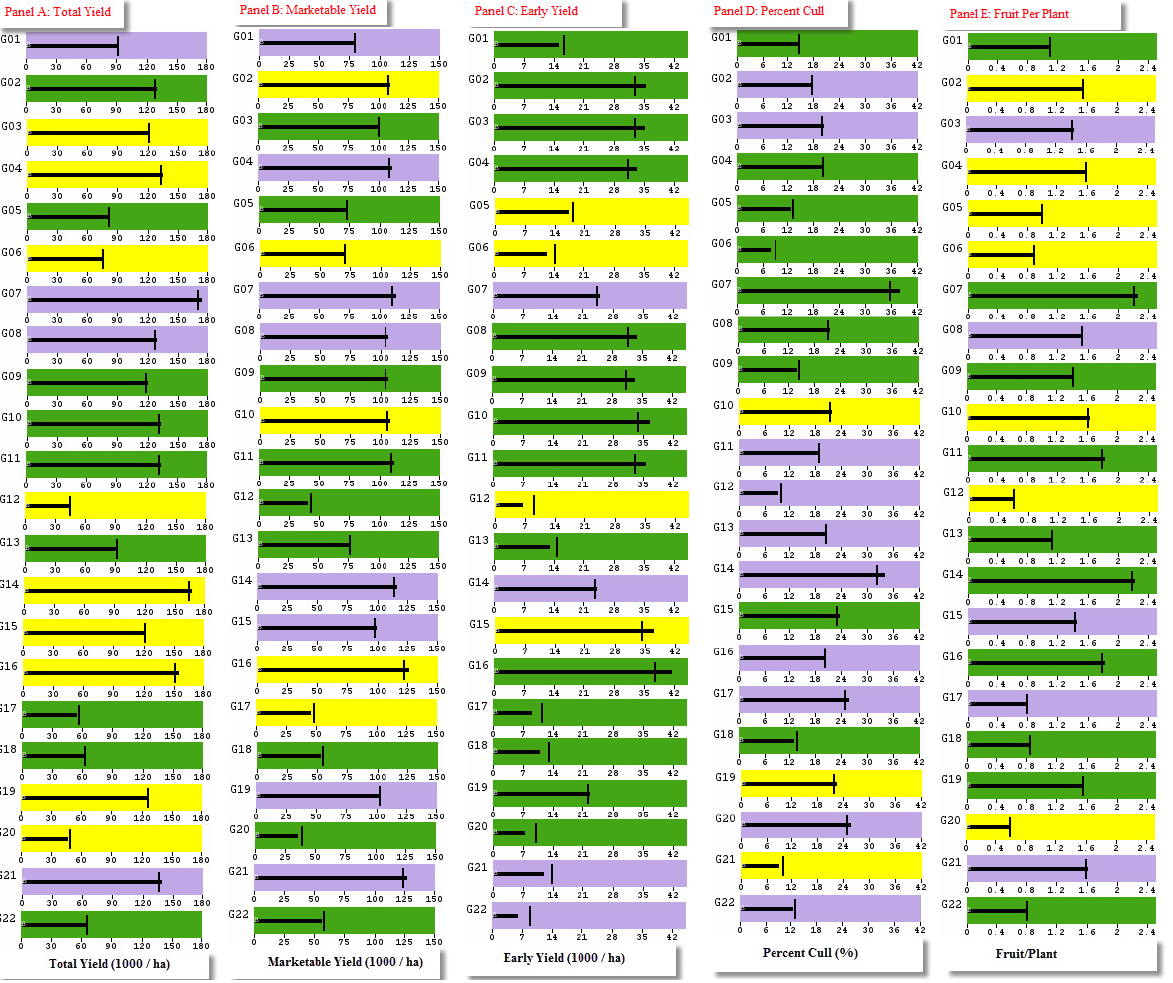
Figure 7: Bullet graph summary of stability statistics, mean and BLUP of 22 cucumber genotypes tested in 3 years and 24 environment for total yield (Panel A), marketable yield (Panel B), early yield (Panel C), percent cull (Panel D) and fruit plant -1 (Panel E). The horizontal bars represent genotype (G01-G22). Back ground fill color of green, yellow and violet within each horizontal bar represent high, medium and low stability. The horizontal and vertical black line within each horizontal bar measure trait mean and BLUP, respectively, on quantitative scale (x-axis). Key to the labels of genotype is presented in abbreviation